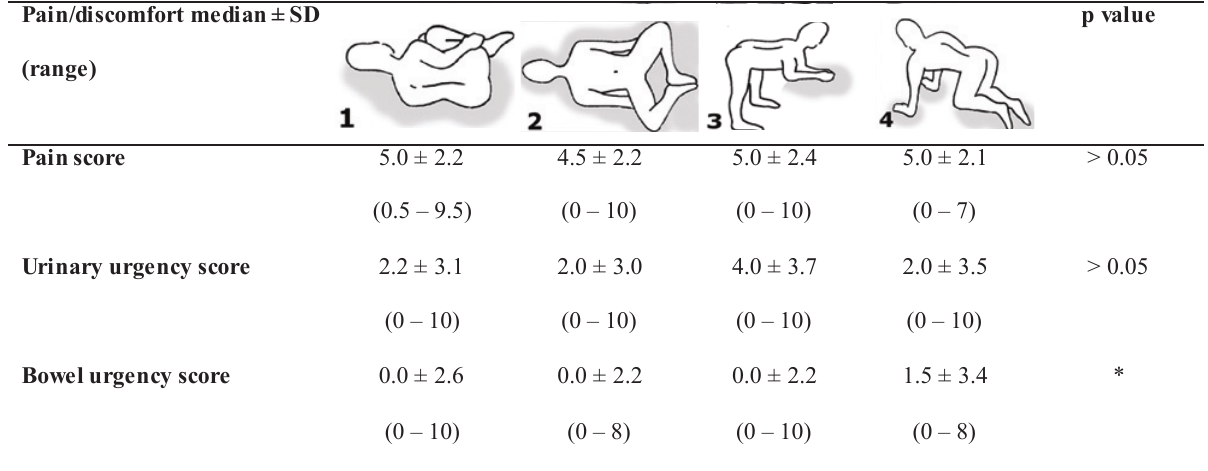
Table 3 - Patient tolerability of DRE.